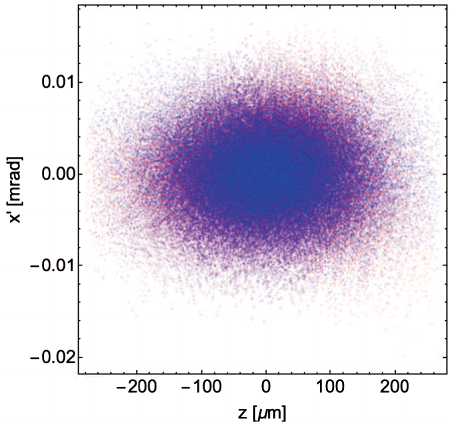
FIG. 6. Phasespacesat theexit ofthe TCBCat250 MeVwiththe tuned voltage Δ V ¼ þ 26 . 5 kV in the last TCAV for the linear (blue) and nonlinear (red) regimes for β x;y ¼ 59 m and α x;y ¼ 2 . 1 .